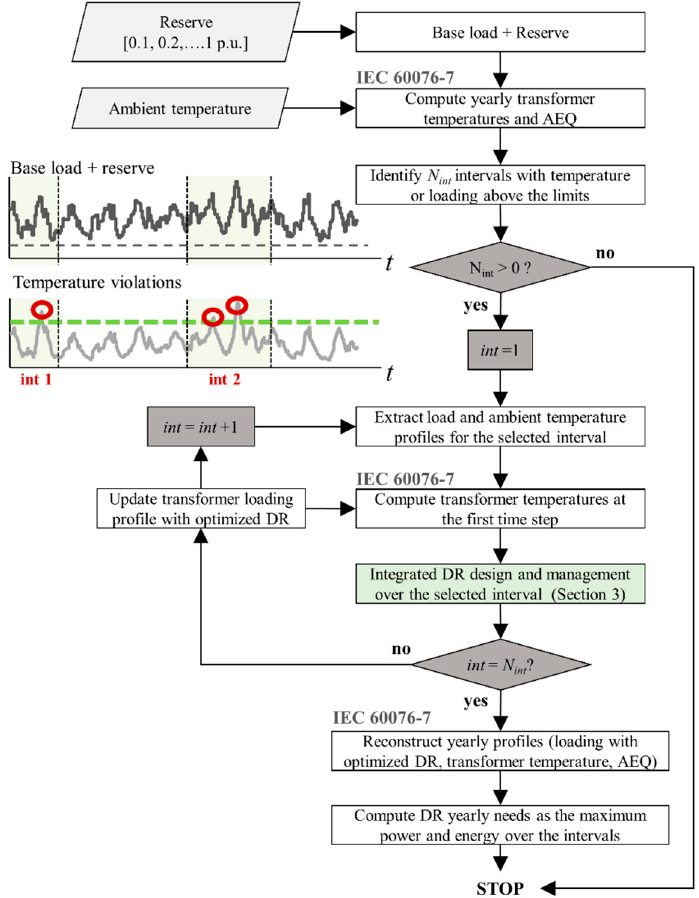
Figure 5. The procedure for finding the needed Demand Response (DR) volume to interconnect the studied reserve.